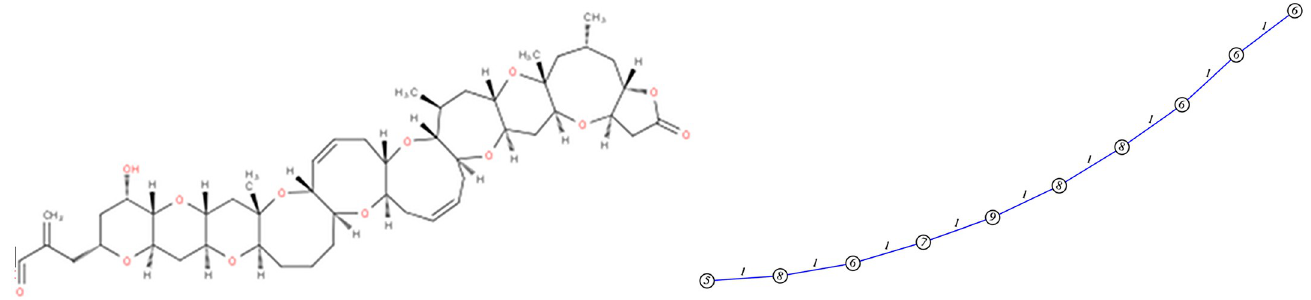
Fig 11. Molecular graph and graph of cycles of Brevetoxine A. According to the definition of the graph of cycles, we compute the graph of cycles of the molecule Brevetoxine A.